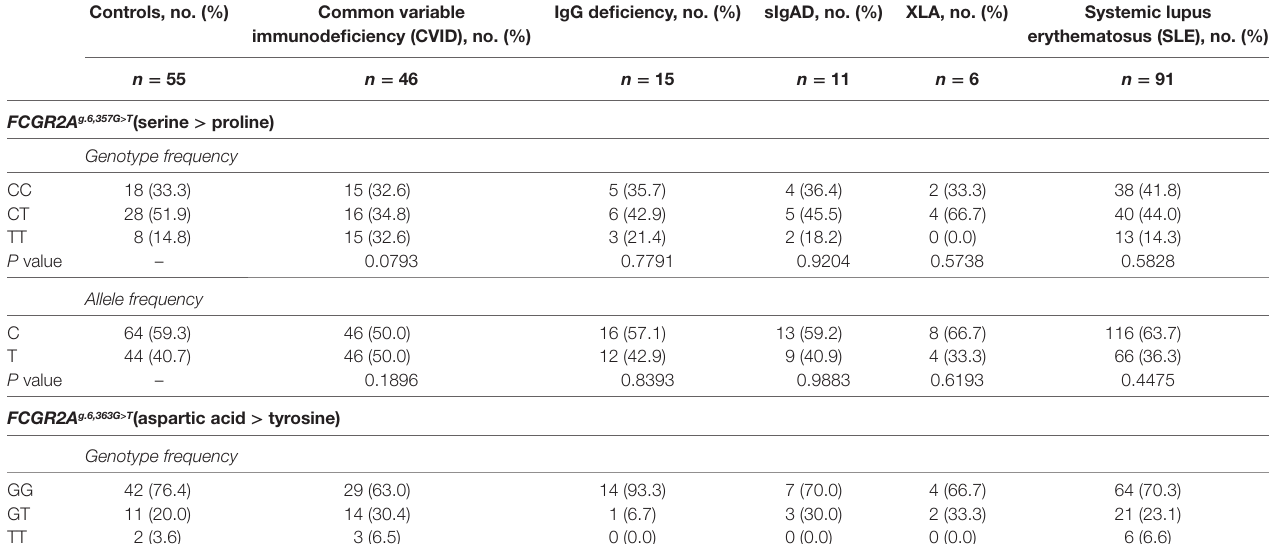
TaBle 1 | Analysis of intronic and exonic SNP associated with FCGR2A C1 exon a . controls, no.